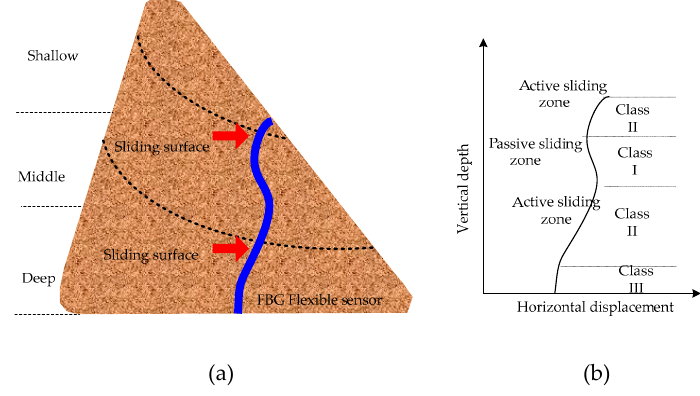
Figure 3. ( a ) Schematic diagram of the internal displacements of the slope monitored by the flexible sensor; ( b ) Internal displacement profiles of the